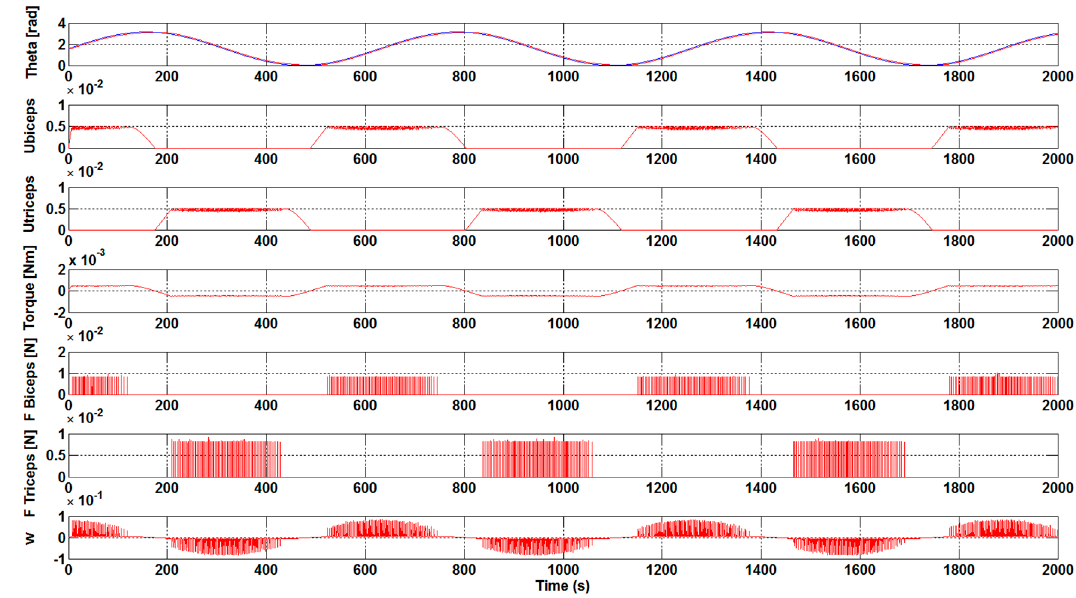
Figure 3. Results without the optimization algorithm and with a K control gain value of 0.1.